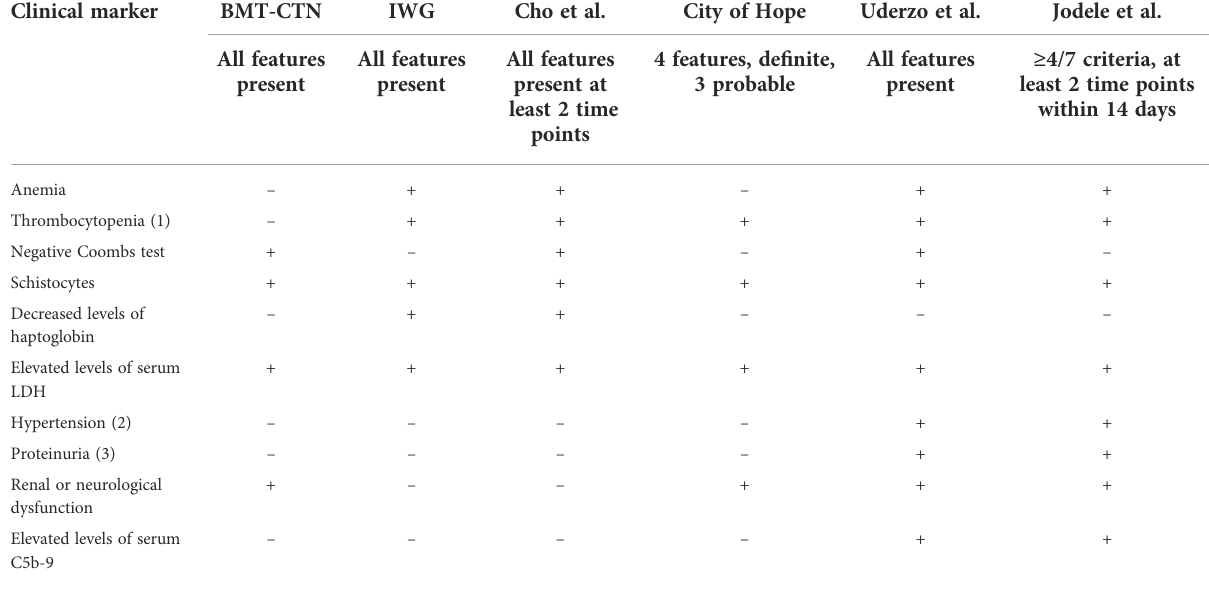
TABLE 1 Clinical diagnostic criteria for